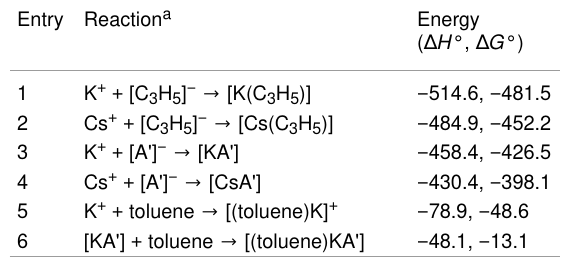
Table 1: Energies of reaction (B3PW91-D3BJ, kJ mol − 1 ). Entry Reaction